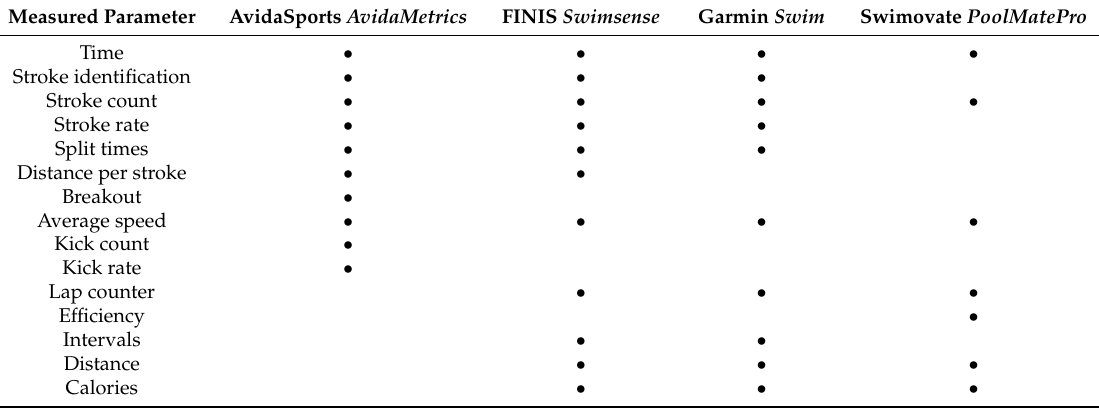
Table 7. Details of system functionality provided by commercially available swimming sensor devices. The features described are similar to those described in research studies for the analysis of swimming performance.